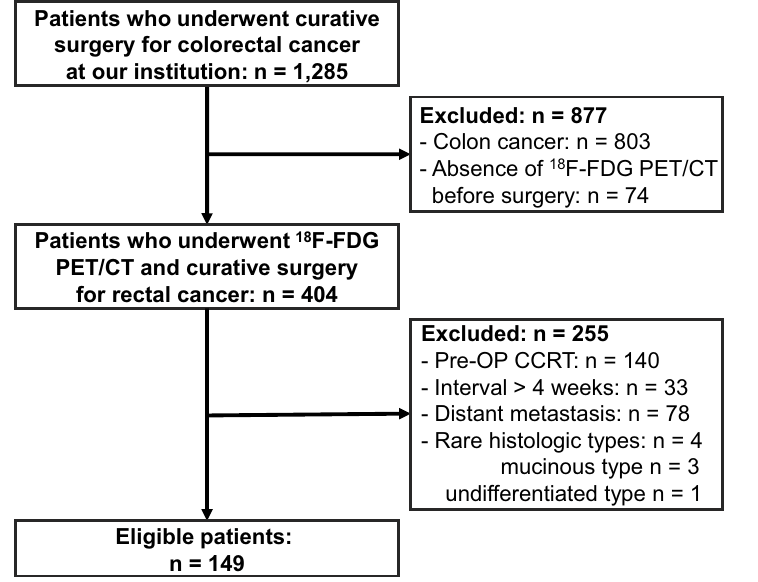
Figure 1. Flow chart of patient